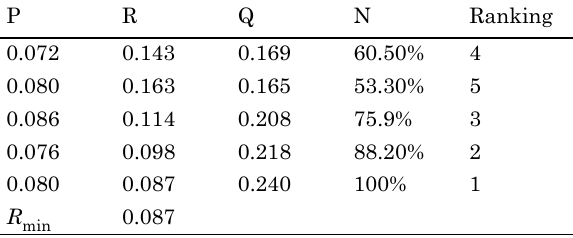
Table 7. Final results and